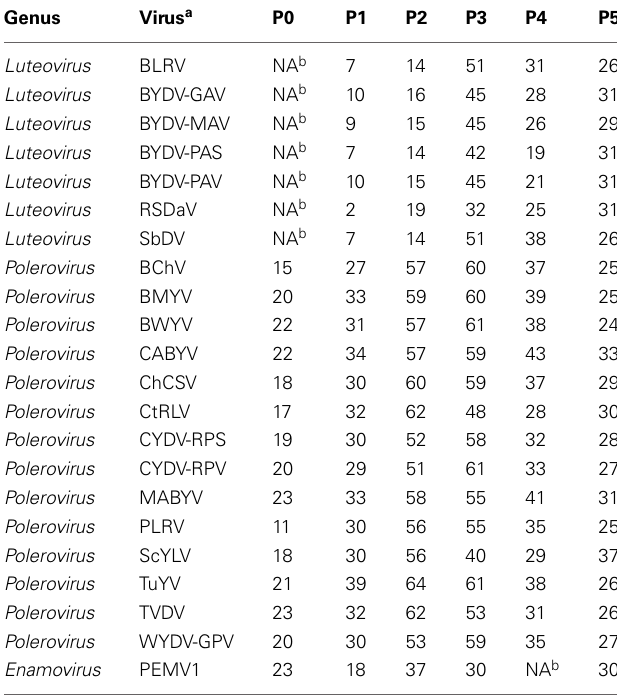
Table 2 | Sequence identity (%) a of BYDV-RMV proteins to those of other luteovirids.